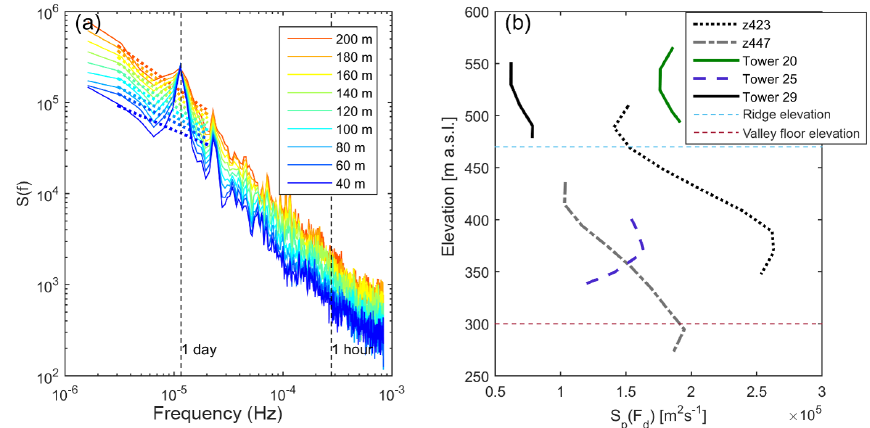
Figure 12. (a) Power spectra of horizontal wind speeds at 10 heights from ZephIR lidar z447 and linear fits defining the trend in each near the frequency of 1 day − 1 . (b) Vertical profiles of the magnitude of the diurnal peak in wind speed variance S p , from each ZephIR lidar and the sonic anemometers deployed on each 100m tower. Measurement heights are shown by their elevation above sea level. The towers and lidars are denoted by the color scheme introduced in Fig. 1. Ridge and valley floor elevations are also shown.